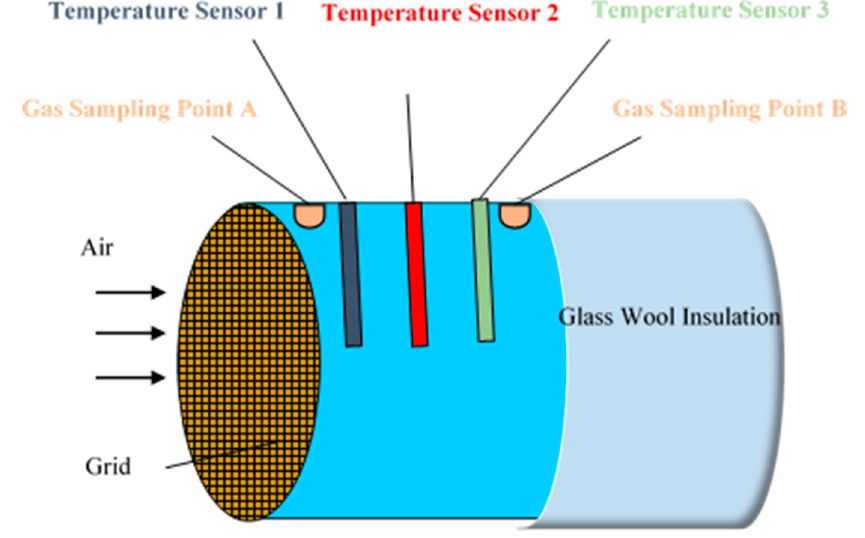
Figure 1. Schematic illustration of the experimental setup (modified according to Jungbluth et